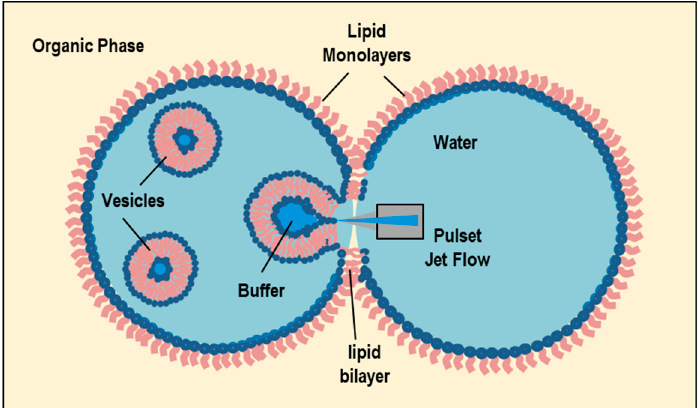
Figure 15. Schematic representation of the pulsed jet flow method. The lipids initially dissolved in the organic phase self-assemble (at the oil–water interface) as monolayers. The periodic pulses of a fluid jet (of a buffer) is directed at the interface of two nearby W/O microemulsions, and favors the formation of giant unilamellar vesicles [133].